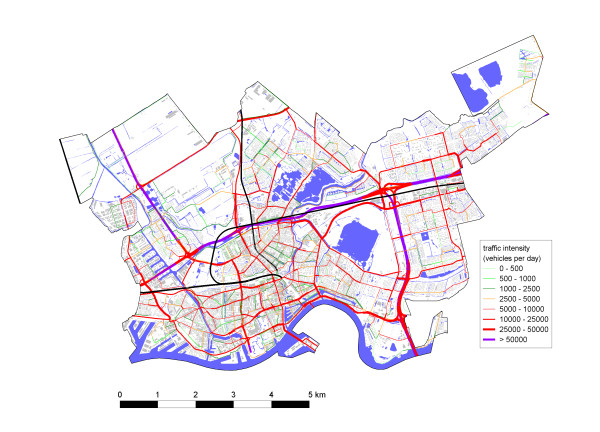
Map of the study area (Rotterdam North) showing the road network and traffic intensities (see legend), rail network (black lines), residences (in grey), and surface water (in blue).